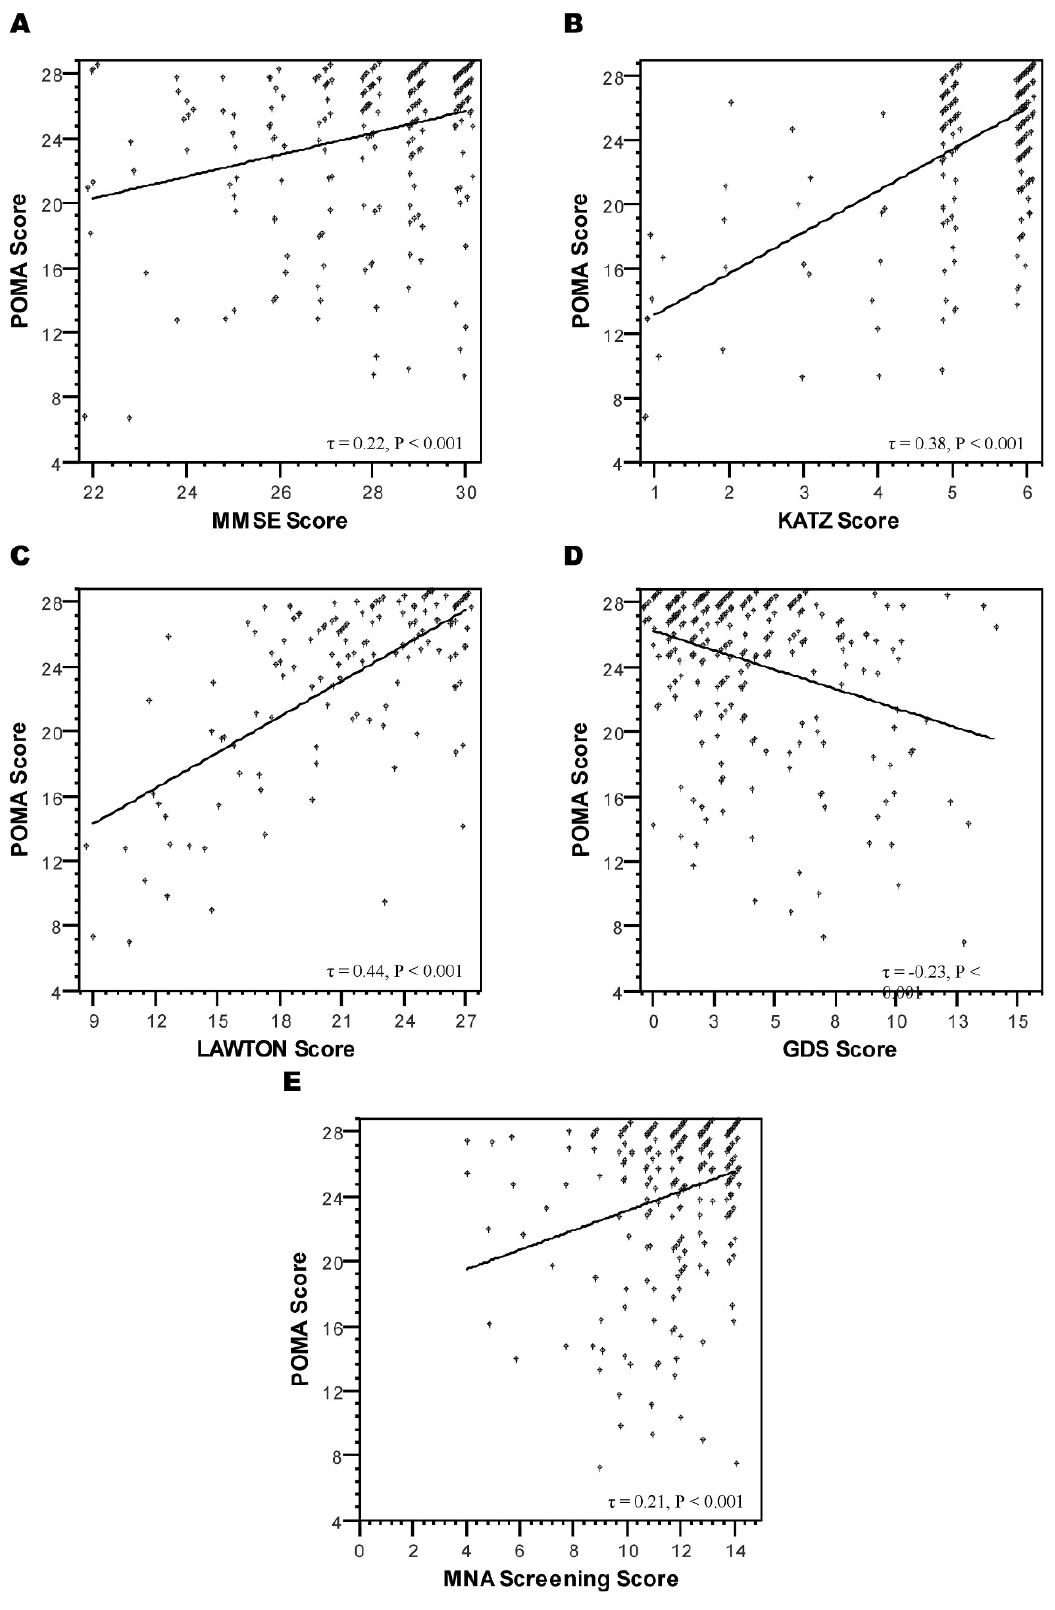
Figure 3 - Graphs depicting the correlations between the POMA score and the MMSE (A), Katz (B), Lawton (C), GDS (D) and MNA (E) scores. Note that the POMA score was positively correlated with all but the GDS score, for which higher values indicate a higher risk of